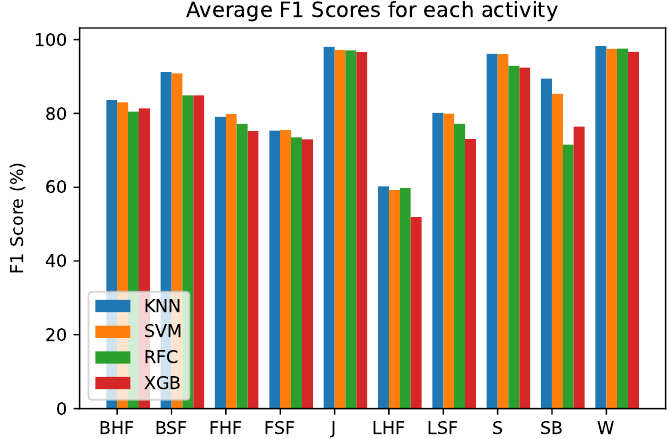
Figure 3. Average F1 Scores for each activity for the four